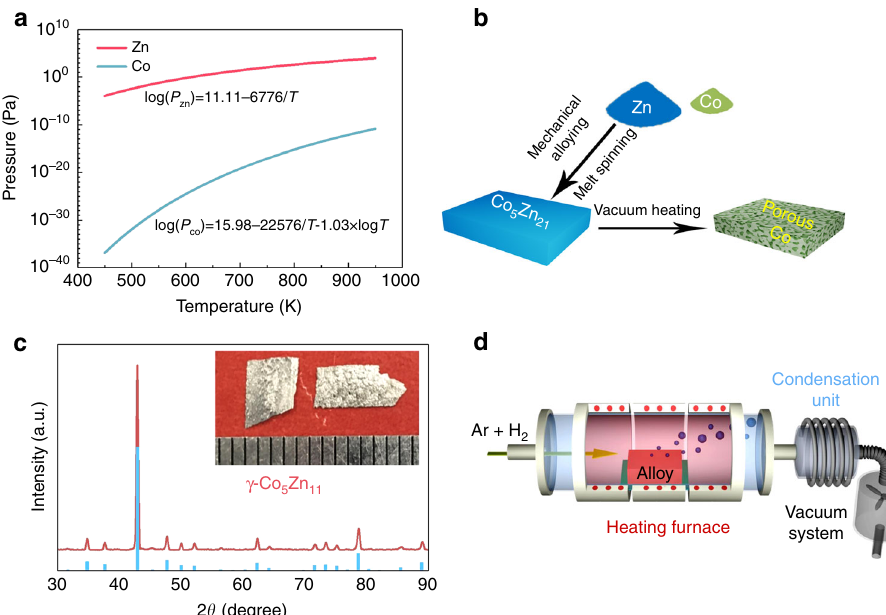
Fig. 1 Vapor-phase dealloying and preparation of a prototype Co 5 Zn 21 precursor. a The relation between temperature and saturated vapor pressure of zinc and cobalt in a prototype Zn – Co alloy system. b The schematic illustration of the fabrication process of nanoporous cobalt. c XRD pattern of Co 5 Zn 21 precursor ribbons and corresponding PDF standard card of γ -Co 5 Zn 21 . The inset shows a photo of Co 5 Zn 21 precursor ribbons. d The schematic of the high- vacuum recyclable vapor-phase dealloying